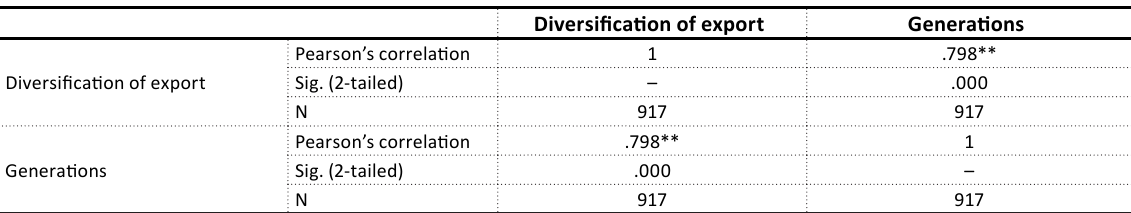
Table 2. Correlation analysis of variables: diversification of export and